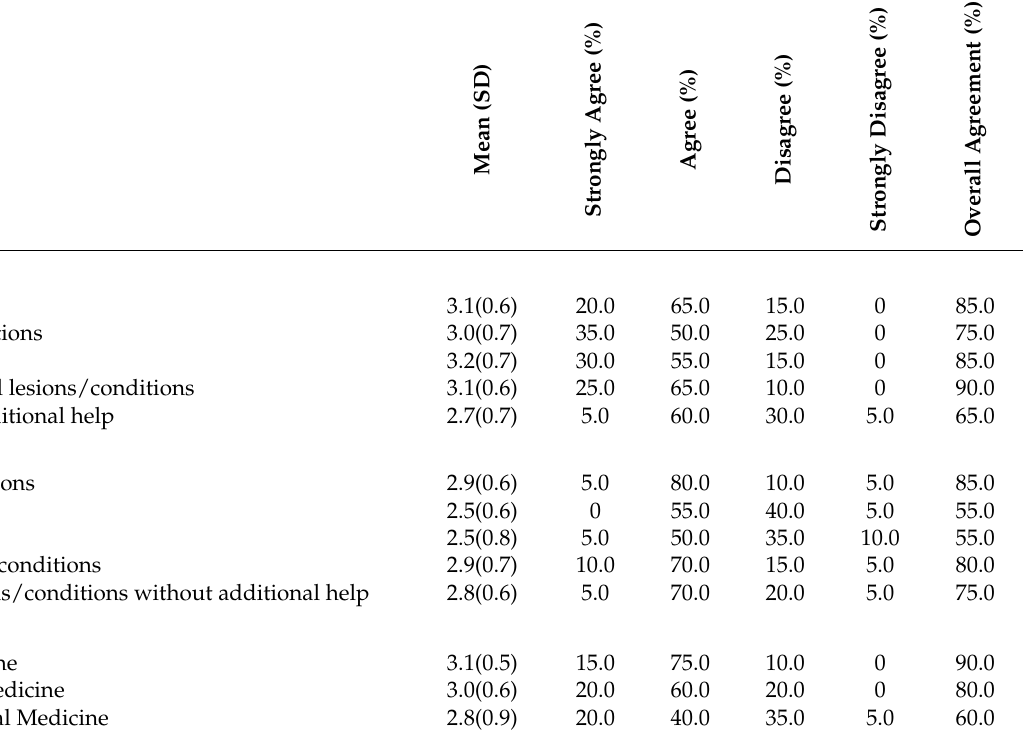
Table 4. Distributions of students’ perceived usefulness of VOMC ( n =